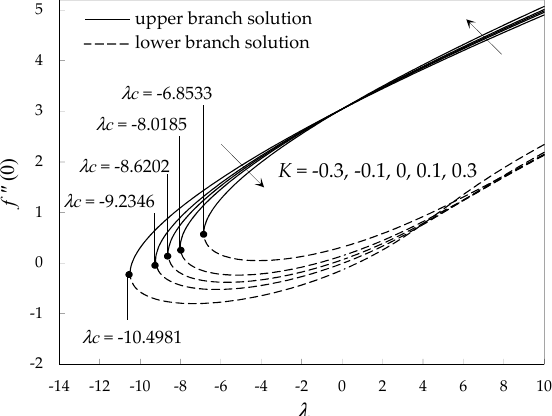
Figure 5. Variation of the reduced local Nusselt number −𝜃′(0) with the mixed convection parameter λ for several values of the radiation parameter Nr when φ = 0.01, K = − 0.1, s = 1 and c = − 1 for Cu-water nanofluid.